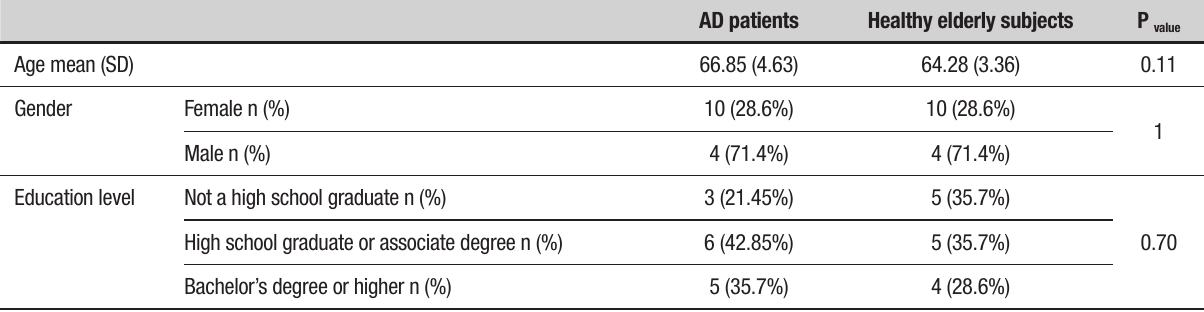
Table 1. Demographic information for patients with Alzheimer’s disease and healthy elderly subjects.